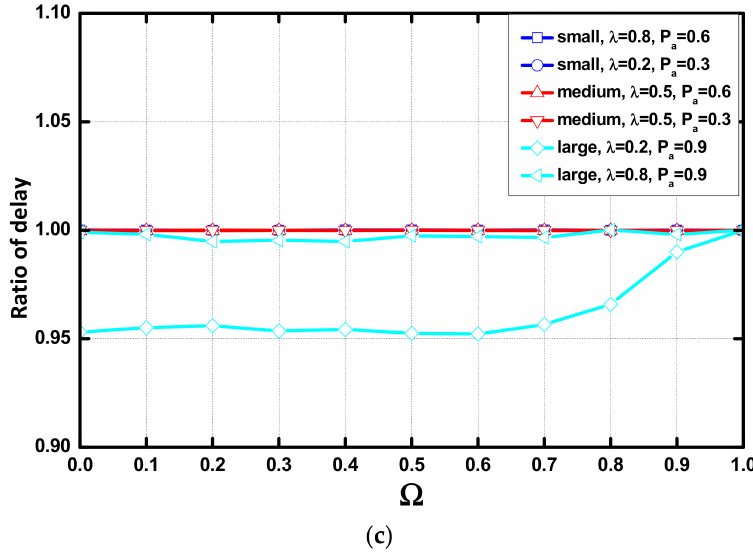
Figure 16. Ratio of delay vs. Ω ( a ) N t = 5; ( b ) N t = 15; ( c ) N t =